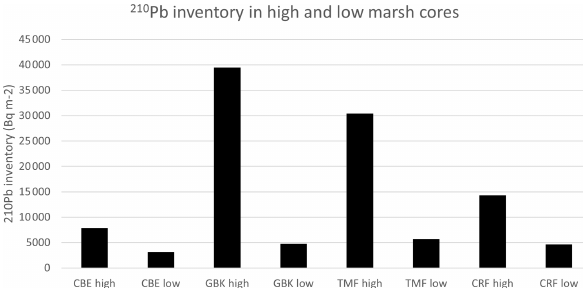
Figure A5. 210 Pb inventory (Bqm − 2 ) in high and low marsh